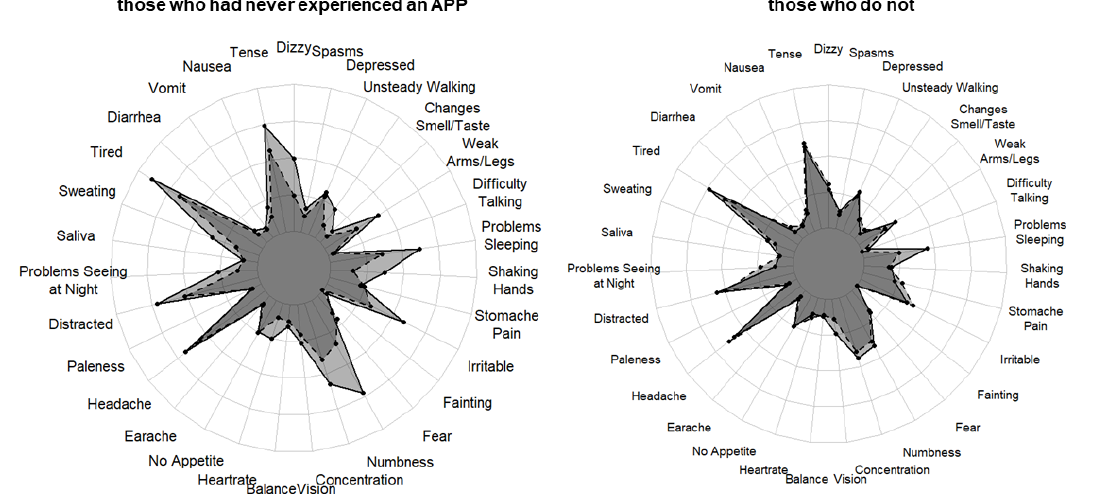
Figure 1. A comparison of the mean frequency of symptoms reported during the 12 months prior to interview by farmers who had experienced at least one APP ( n = 43, in light gray) vs. those who had never suffered from an APP ( n = 257, in dark gray) is on the left. As a sensitivity analysis, a comparison of the mean frequency of symptoms reported during the 12 months prior to interview by farmers currently applying synthetic pesticides (e.g., conventional farmers, n = 220, in light gray) vs. those who do not currently apply synthetic pesticides (e.g., organic farmers, n = 80, in dark gray) is on the right. Symptom frequency was rated on a scale from 1 (one time in the year) to 4 (more than once a week). The frequency of symptoms was higher among farmers who had experienced an APP vs. those who had not (Figure 1, two-way ANOVA results F = 2.04, p < 0.001). The greatest